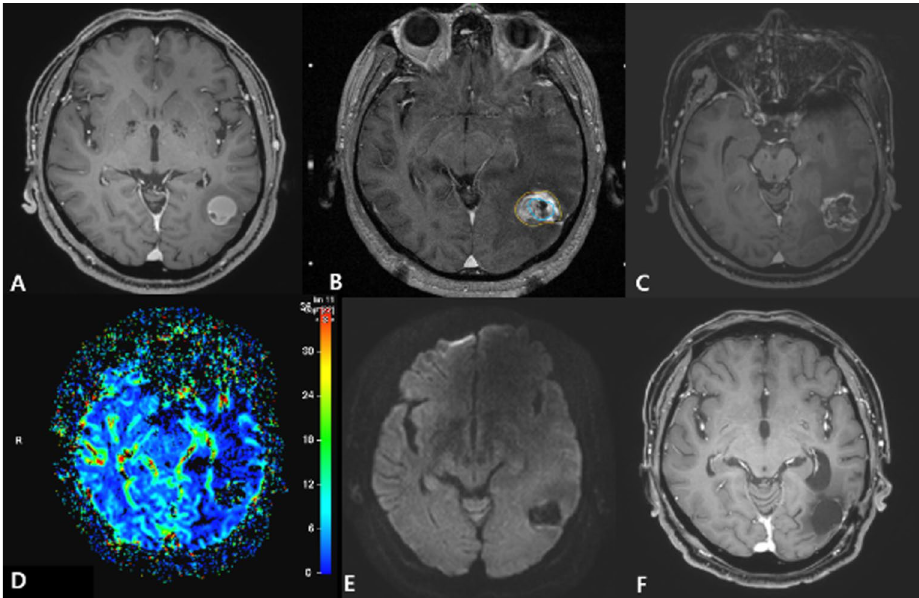
Figure 2. An illustrative case of TRC-PD. A 73-year-old male patient with non-small cell lung cancer was diagnosed with a 2.9 cm brain metastatic lesion in the left temporo-occipital junction ( A ). GKS with an initial prescription dose of 20 Gy at 50% IDL was performed. Due to suspicion of tumor progression at 11 months after the first session, a secondary prescription dose of 17 Gy at 50% IDL was administered ( B , IDL of the second GKS [yellow] and previous session [blue]). At 9 months from the last GKS, the patient visited the emergency room with IICP signs, and MRI showed a lesion resembling TRC with no distinct increase in rCBV and absence of restricted diffusion ( C – E ). Surgical resection was conducted and the pathology was confirmed to be a pure metastatic tumor cells. Without adjuvant local therapy for the resected lesion, the patient was free of local progression for 15 months ( F ). IDL isodose line, IICP increase of intracranial pressure, PD progressive disease, rCBV relative cerebral blood volume, TRC treatment-related image